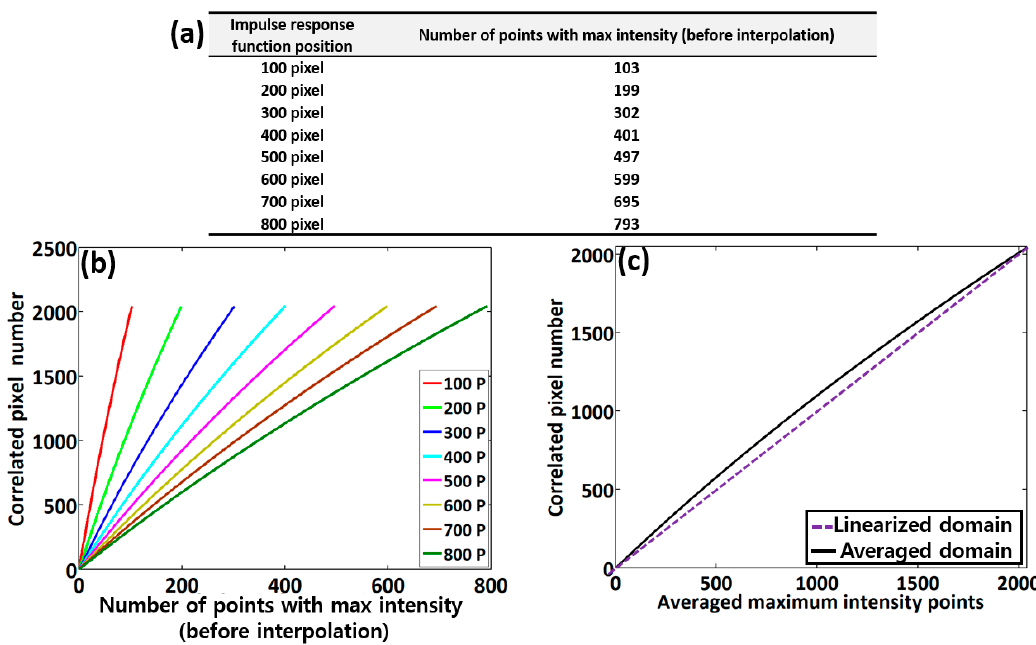
Figure 4. Evaluations of the point spread function (PSF)-based spectral interferogram analysis. ( a ) The depth information table of each PSF position, showing the respective number of points carrying maximum intensity, ( b ) correlated pixel numbers (pixel positions) at each number of points with maximum intensity prior to interpolation, and ( c ) the averaged graphical plot of the eight respective graphs in Figure 4b.